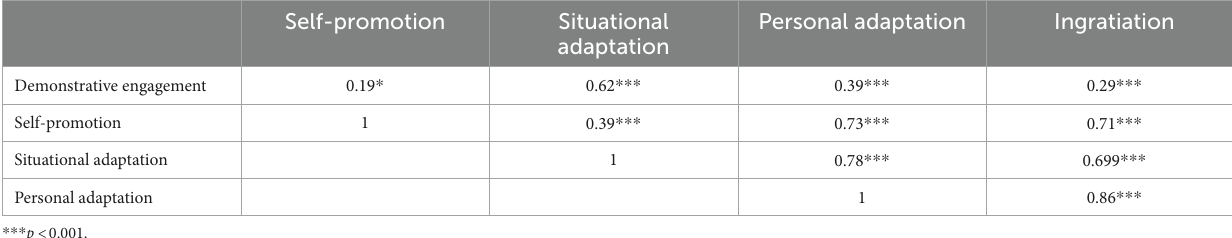
TABLE 2 Correlations between latent dimensions of self-presentation.